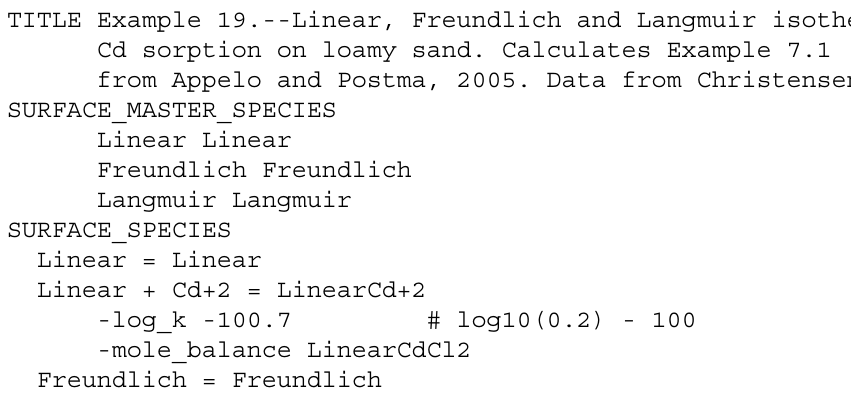
Table 55. Input file for example 19. TITLE Example 19.--Linear, Freundlich and Langmuir isotherms for Cd sorption on loamy sand. Calculates Example 7.1 from Appelo and Postma, 2005. Data from Christensen,